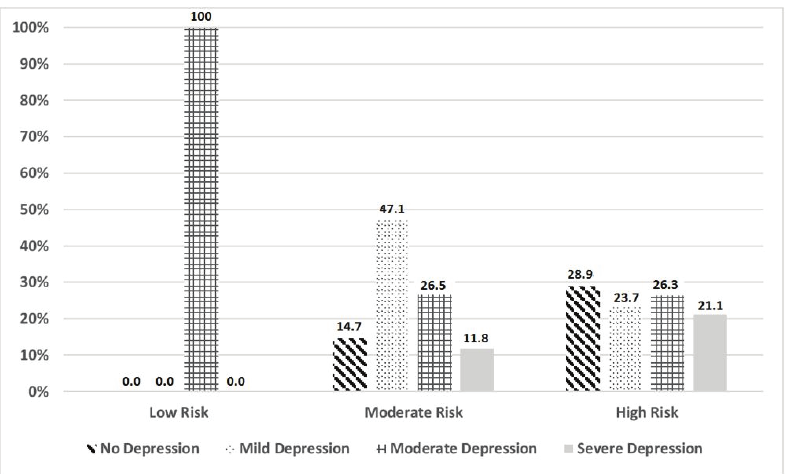
Figure 1. The prevalence of various severities of depression among ophthalmologists working in different regions of Iran in